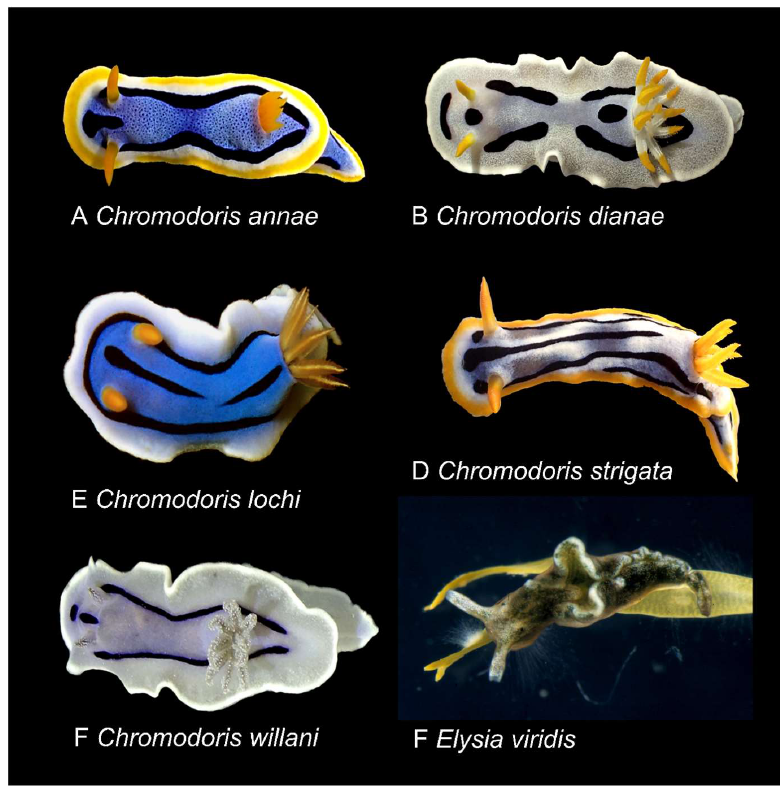
Figure 3. Photographs of the investigated Chromodoris species ( A – E ) and Elysia viridis ( F